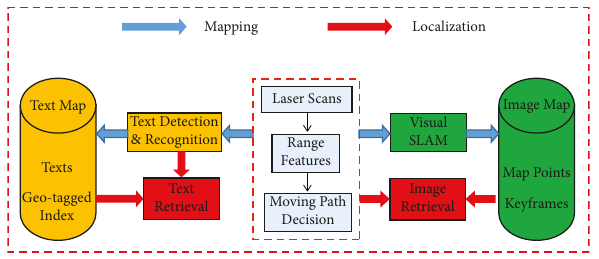
Figure 1: Framework of the mapping and localization